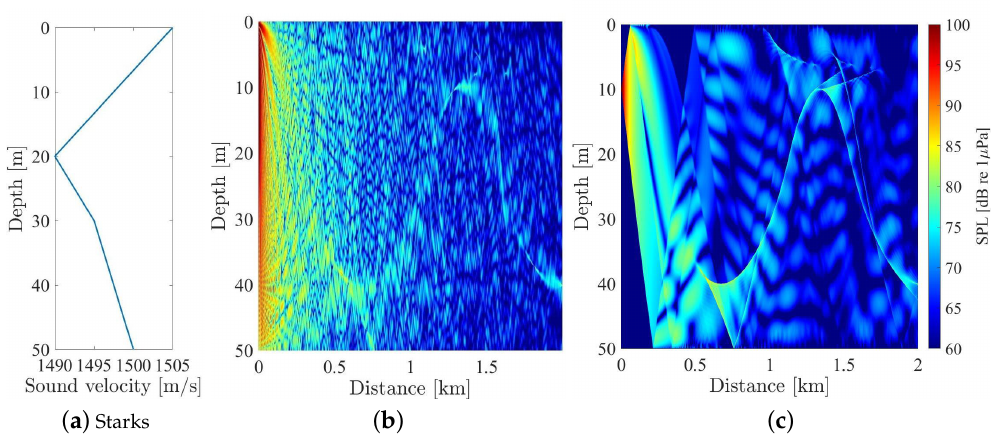
Figure 10. Behavior of a signal propagated in water with a conventional and a parametric transducer. ( a ) Sound speed profile in seawater; ( b ) acoustic fields generated with an omnidirectional source; ( c ) acoustic fields generated with an directional source one of ± 10 ◦ .